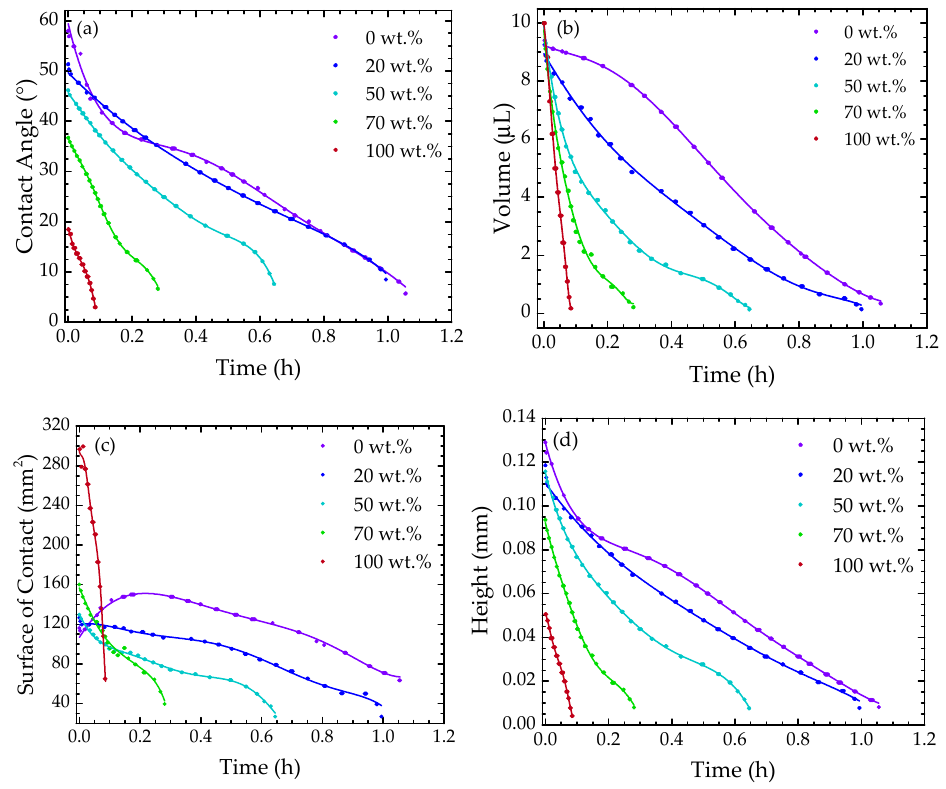
Figure 9. ( a ) Contact angle, ( b ) droplet volume, ( c ) surface of contact, and ( d ) height with regard to time for each mixture under study.